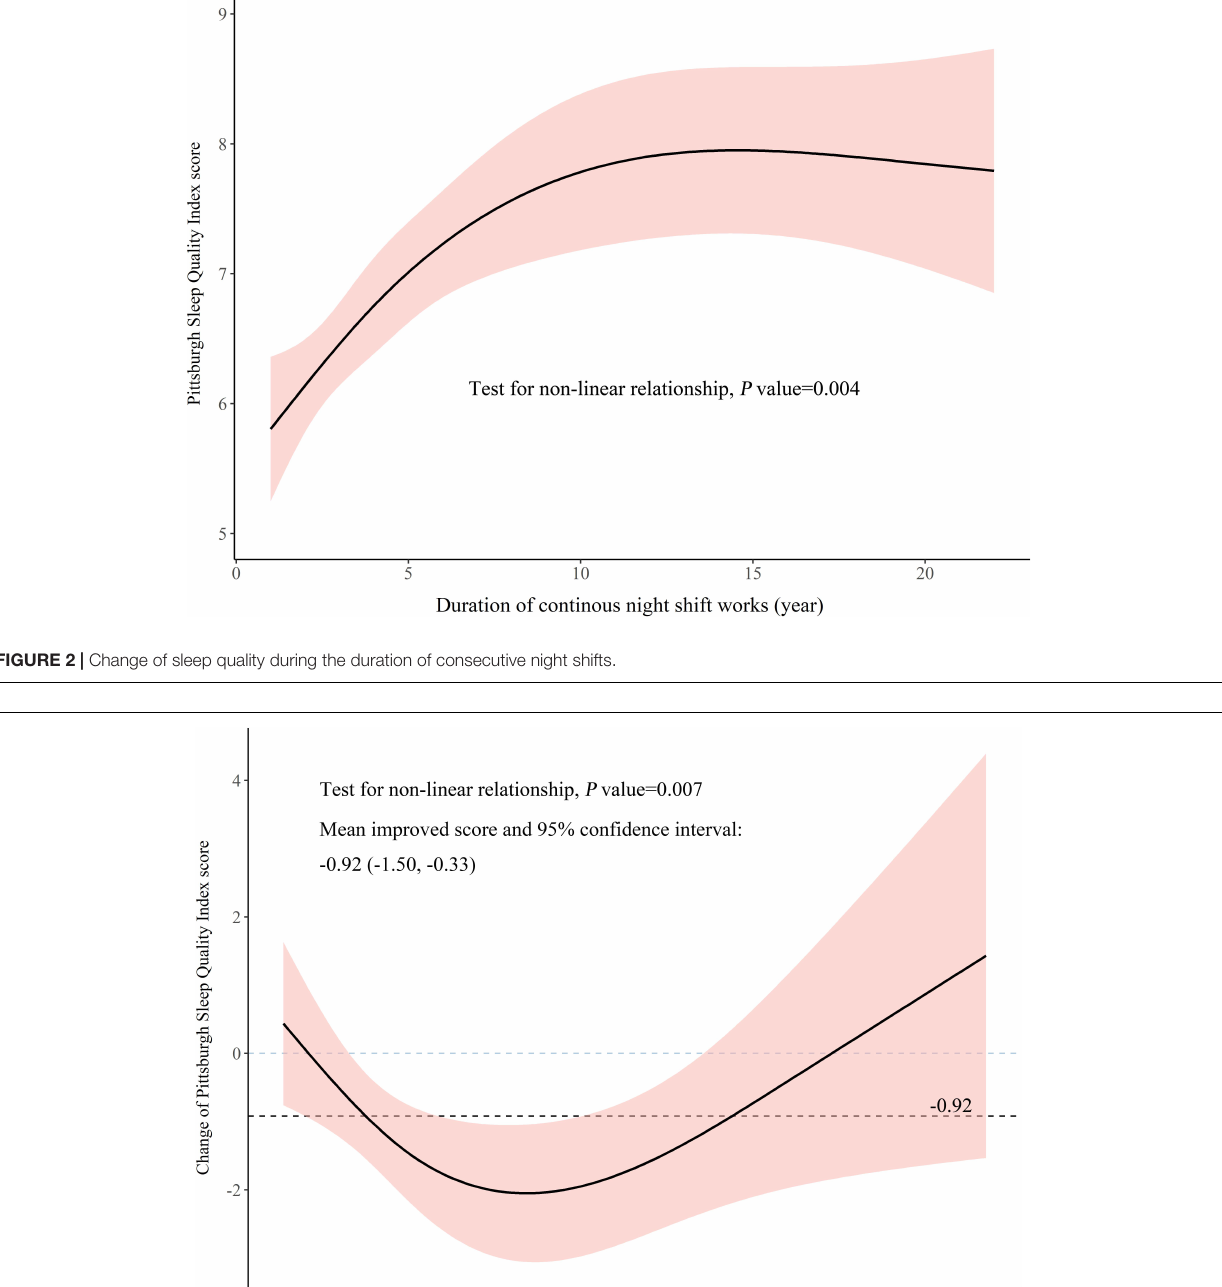
− 1.50 to − 0.33), the change was consistent with − 0.91 (95% CI: − 1.43 to − 0.40) in 686 participants, which suggested that the constructed pairs were a representative subset of total participants. A U-shaped relationship between hypothetical years after quitting night shift and change in PSQI score was observed,